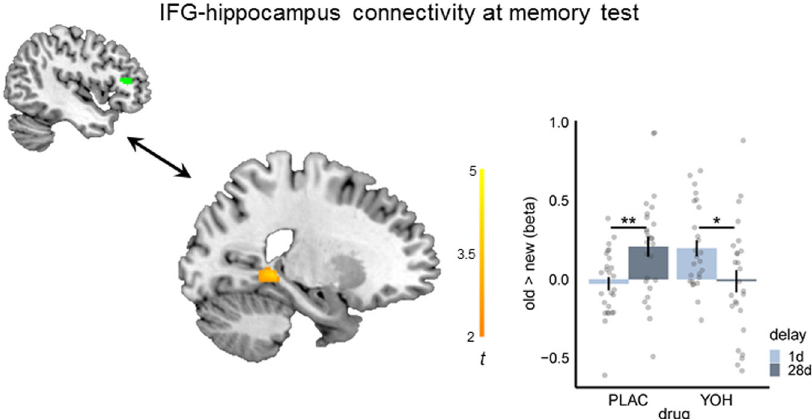
Fig. 3 Noradrenergic stimulation reverses the time-dependent changes in IFG-hippocampus functional connectivity. Psychophysiological interaction analysis indicated that while the connectivity between the inferior frontal gyrus (IFG) and hippocampus increased in the placebo (PLAC) group from 28d relative to 1d ( p = 0.004 two-tailed Welch ’ s t -test), there was even a decrease in IFG-hippocampus connectivity at 28d compared to memory testing after 1d in the yohimbine (YOH) group ( p = 0.020, two-tailed Welch ’ s t -test; drug × delay, SVC peak-level: x = − 22, y = − 40, z = − 2, p (FWE) = 0.009, mixed ANOVA; n = 104 participants). Bonferroni correction was applied for the number of regions of interest in each analysis. The seed-region in the IFG (green), retrieved from the drug × delay interaction of the univariate analysis (peak: x = − 50, y = 34, z = 12; k = 62), and the signi fi cant cluster in the hippocampus (orange) are superimposed on sagittal slices of T1-weighted template images. Distribution of beta-values for the signi fi cant cluster is presented for the contrast old > new. Bars represent mean ± SEM. Source data are provided as Source data fi le. * p < 0.050, ** p < 0.010.